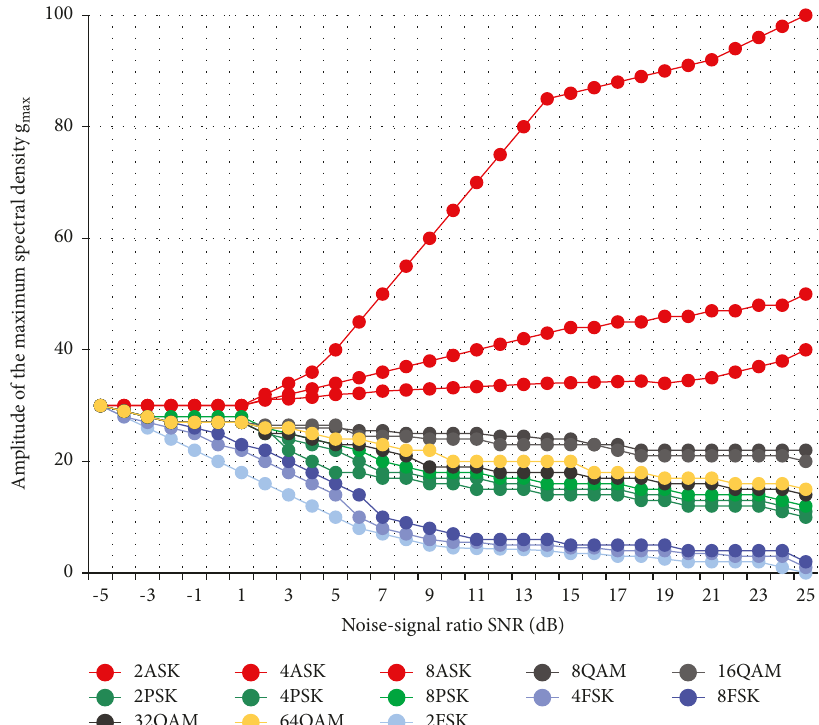
Figure 2: A variation curve of the feature c